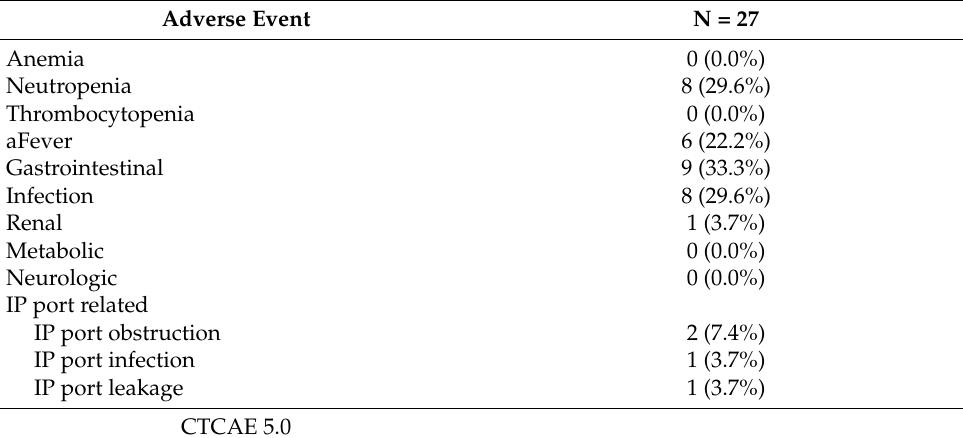
Table 4. Rate of grade 3–4 adverse events during treatment and port-related